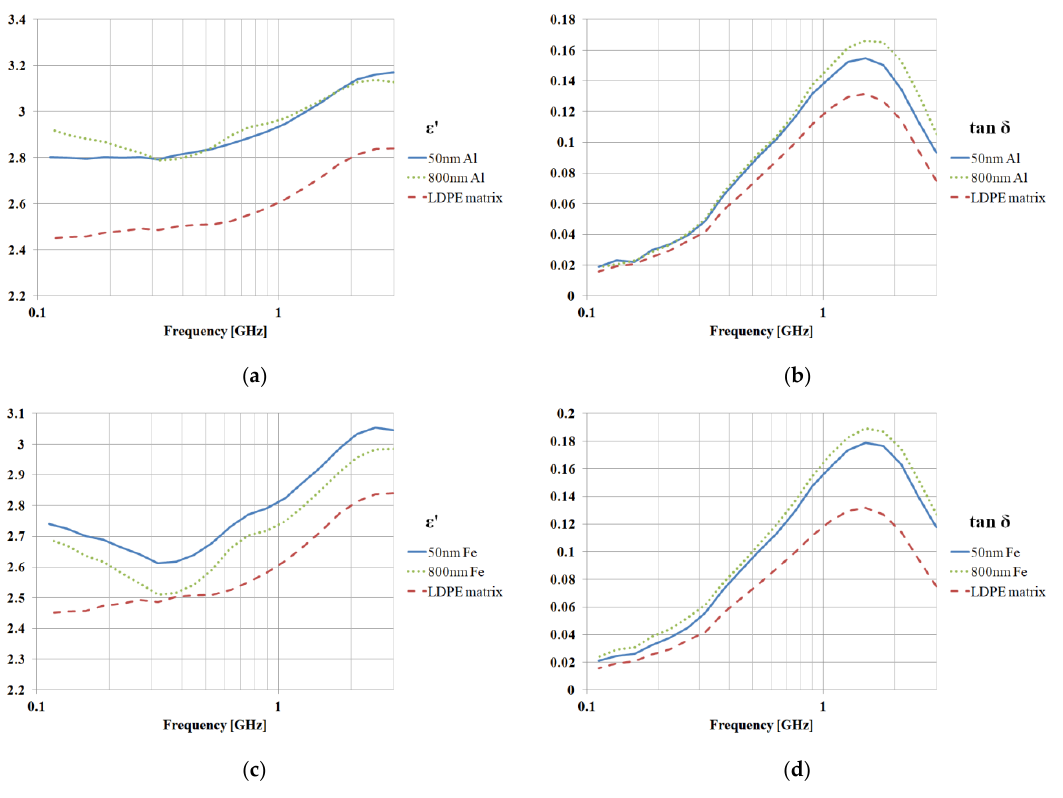
Figure 15. Measurement results, dielectric properties, permittivity, and loss angle tangent, 7% mass ratio; ( a , b ) Al fillers in LDPE matrix; ( c , d ) Fe fillers in LDPE matrix.